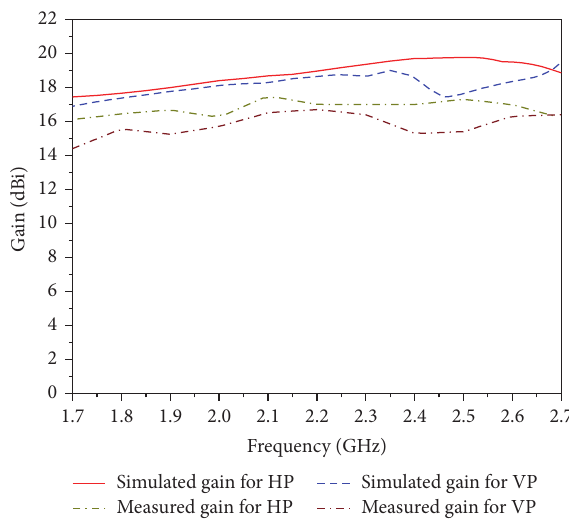
Figure 9: Gains of the V/H dual-polarized antenna